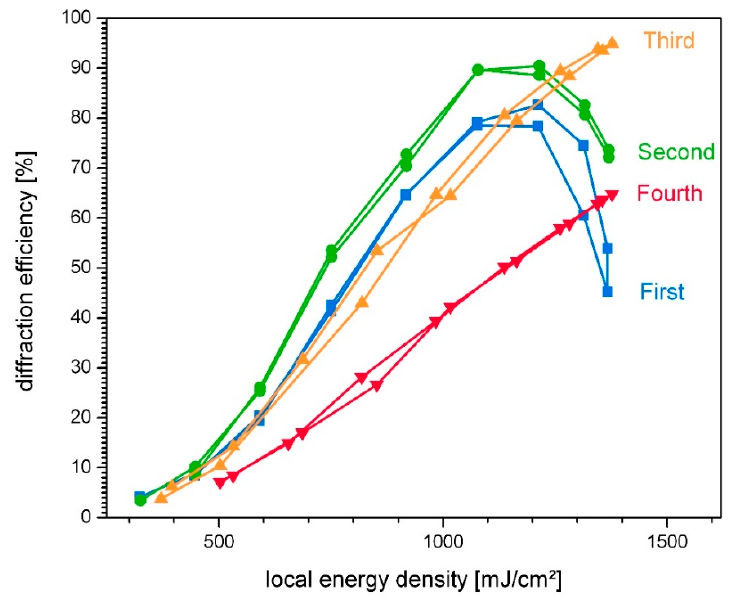
Figure 4. Impact of pre-exposure on the intensity response. All holograms are subsequently exposed (first, second, third, fourth) under equal conditions. Exposure duration was 15 s in each case.